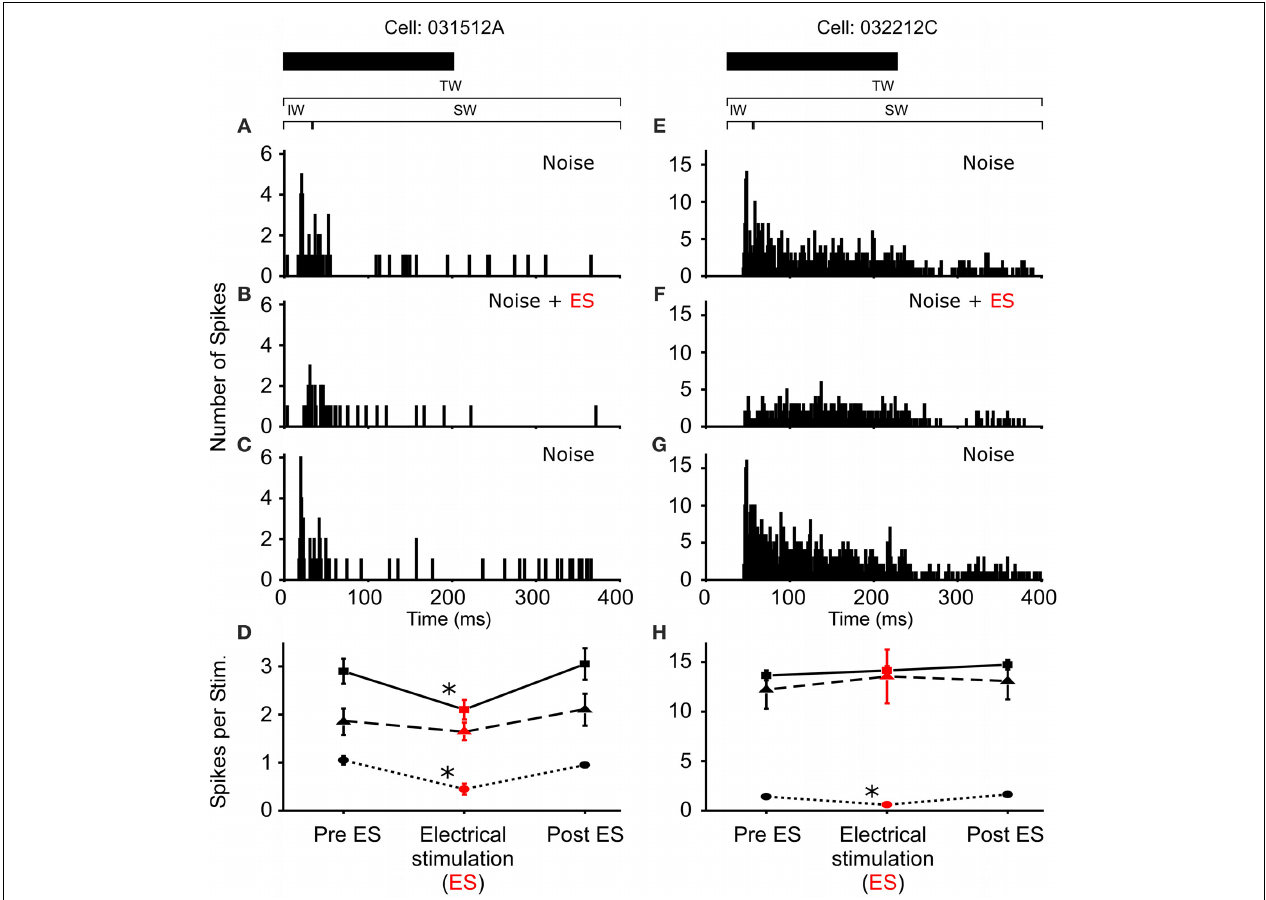
FIGURE 4 | Reduced excitability due to sound-by-sound electrical stimulation. (A–C) PSTHs for a cell exhibiting a reduced response in multiple segments of the spike train. (E–G) Reduced response is found in the initial window, with the other windows showing no significant change. Modulation